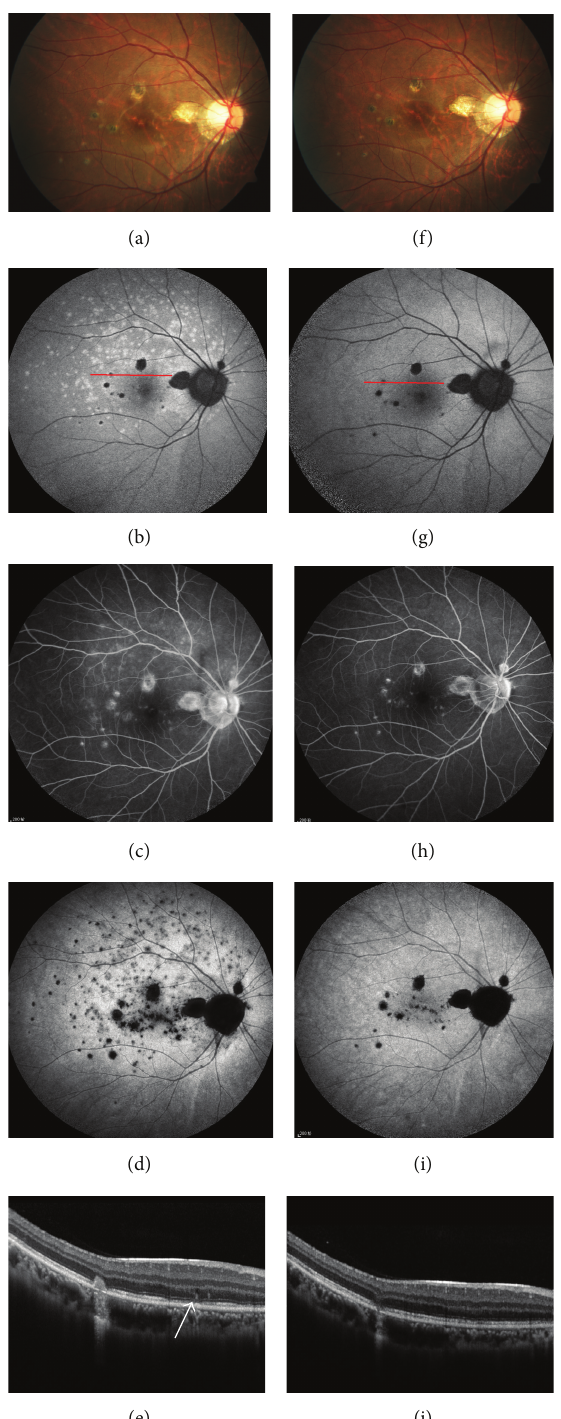
Figure 3: Figure 3: Fundus photography (a, f), SW-FAF (b, g), FA (c, h), ICGA (d, i), and SD-OCT (e, j) of the right eye of a 24-year-old female at the initial visit and 5 weeks later. At the initial visit, her BCVA was 0.2. (a) There were scattered yellowish spots in the upper posterior pole in addition to the yellow-gray PIC lesions. (b) Diffuse hyperautofluorescent areas were shown on SW-FAF, which tended to emerge in the macula and around the optic disc. Additionally, the hypoautofluorescent PIC lesions were surrounded by hyperautofluorescent edge. (c) FA revealed patches of hyperfluorescence, which was especially obvious in late phase and the extent was smaller than it was on SW-FAF and ICGA.The PIC lesions showed hyperfluorescent spots with slight leakage. (d) Hypocyanescent spots were indicated in the late phase of ICGA. (e) The red line (crossing a PIC lesion and hyperautofluorescent areas on SW-FAF) shown on SD-OCT was dome-shaped high reflective materials (arrow), with underlying disrupted EZ. Additionally, an active lesion (stage III) was detected. Five weeks later, the MEWDS lesions faded completely on fundus photography (f), SW-FAF (g), FA (h), and ICGA (i). Meanwhile, the dome-shaped high reflective materials on SDOCT disappeared and disruption of EZ near-completely recovered (j). The hyperautofluorescent margin of the PIC lesion faded on SW-FAF (g). The PIC lesion regressed on SD-OCT (j). Her BCVA was improved to